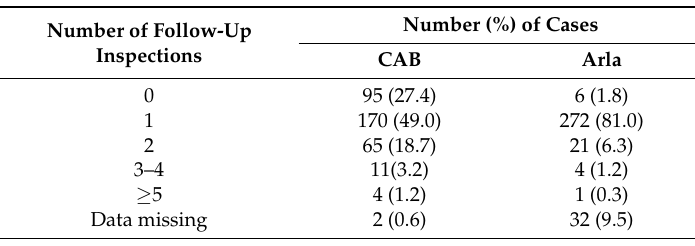
Table 5. Number of follow-up inspections to check for compliance after the first inspection of a case of non-compliance in official animal welfare control (CAB = County Administrative Board) and Arlagården private standard audits (Arla) in the Swedish county of Västra Götaland during 2010–2013. The sums are not 100% due to missing